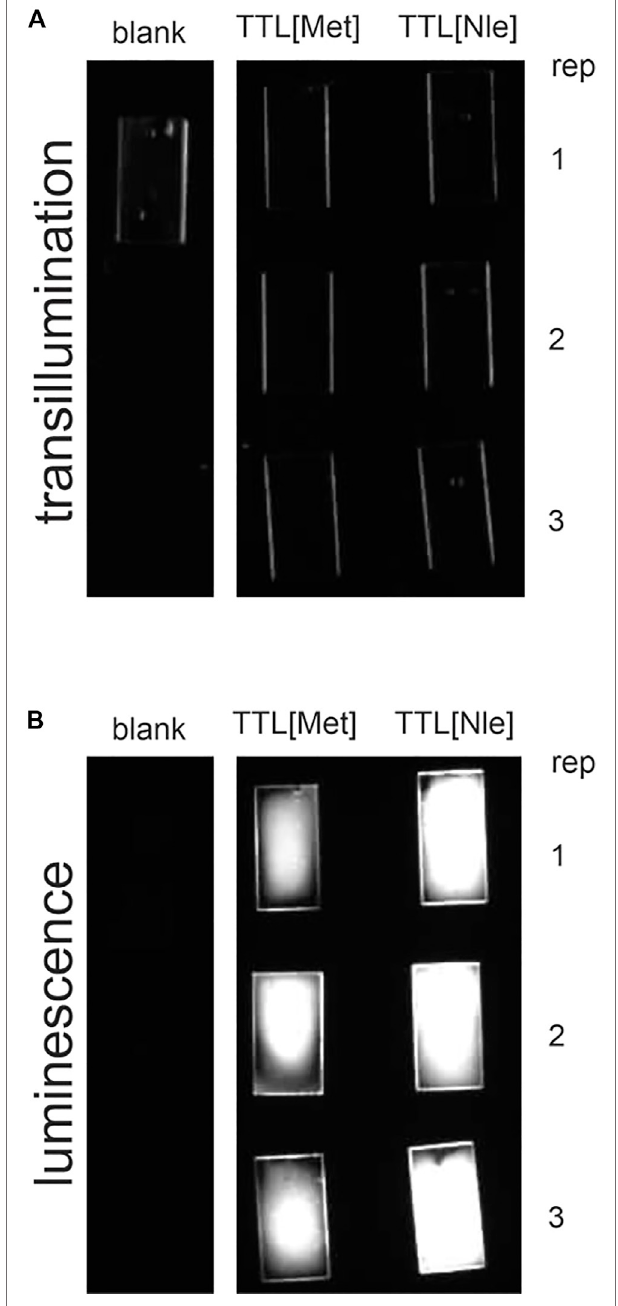
FIGURE 3 | Adhesion of TTL [Met] and TTL [Nle] on PET fi lm. Transillumination (A) ; luminescence after detection of the hexahistidine-tag using HisProbe (B)